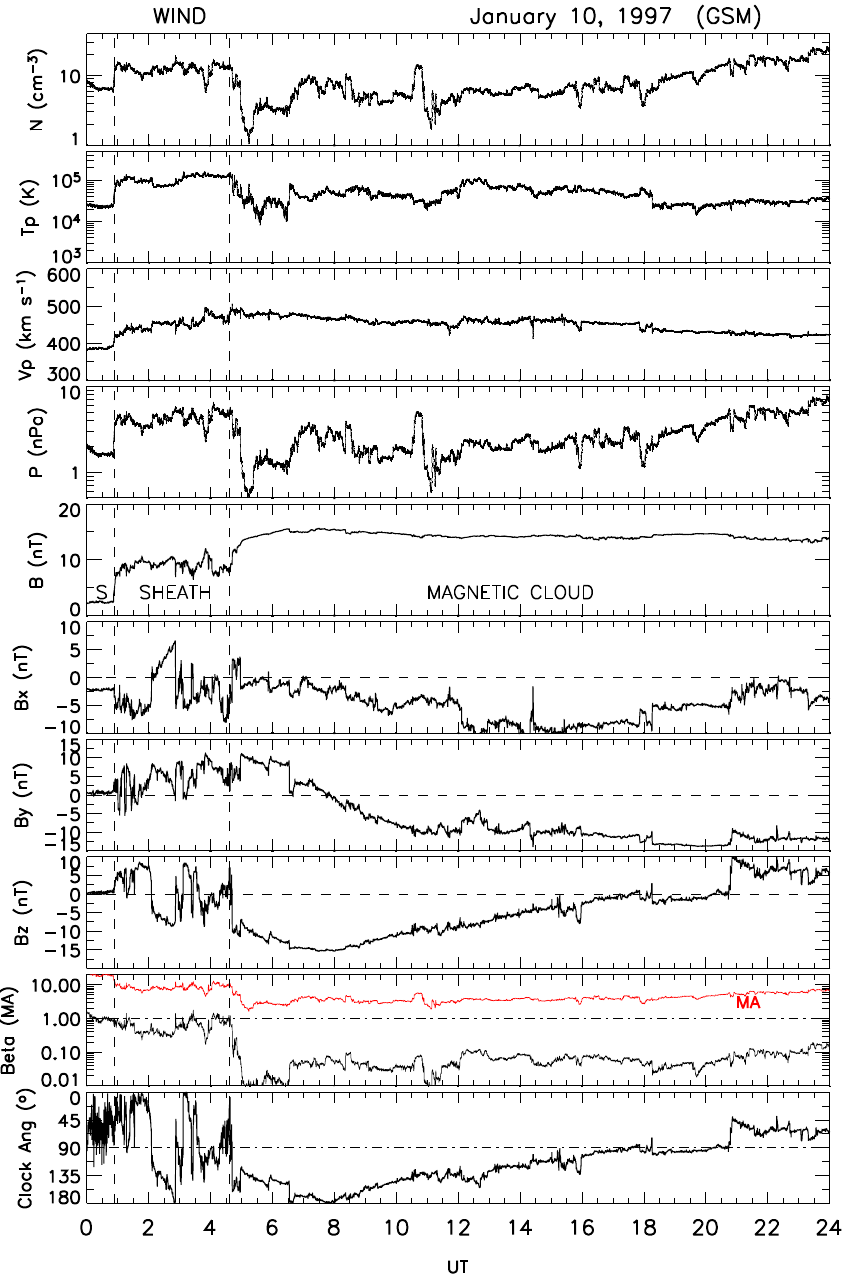
Fig. 23. Solar wind plasma and IMF data for 10 January 1997 obtained from spacecraft Wind. Same format as in Fig. 4.